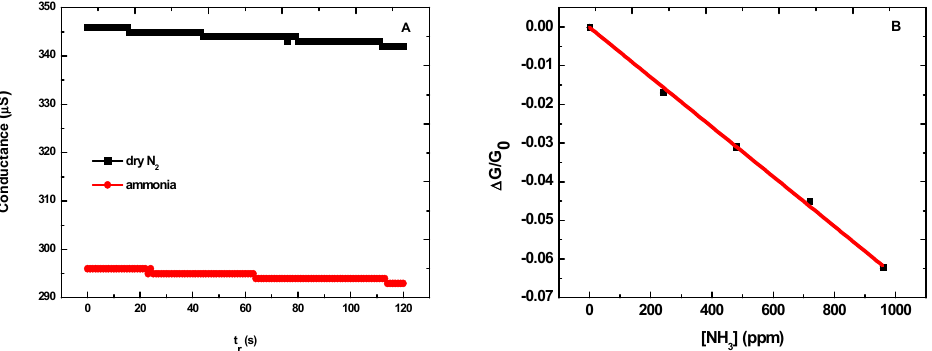
Figure 9. Response of the WS 2 nanoflower-based sensor at RT. ( A ) Conductance under dry N 2 conditions (black curve) and after exposure to 958 ppm of NH 3 (red curve) as a function of time. ( B ) Sensitivity of the WS 2 nanoflowers to NH 3 concentrations ranging from 240 to 958 ppm. Relative variation in the conductance to NH 3 concentrations ranging from 240 to 958 ppm. The solid red line represents the linear fit to the experimental data (black squares). The slope of the fit is the sensitivity of the WS 2 nanoflower-based sensor.